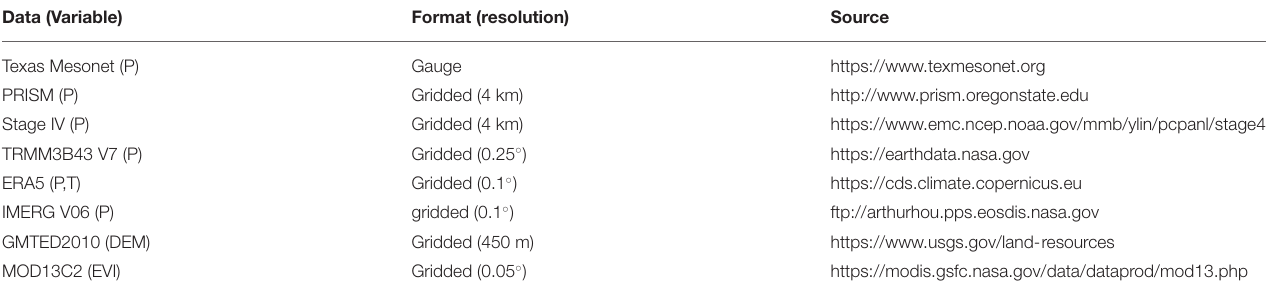
TABLE 1 | Summary of datasets used in this study, where P–precipitation, T–temperature, DEM–elevation, EVI –enhanced vegetation index.